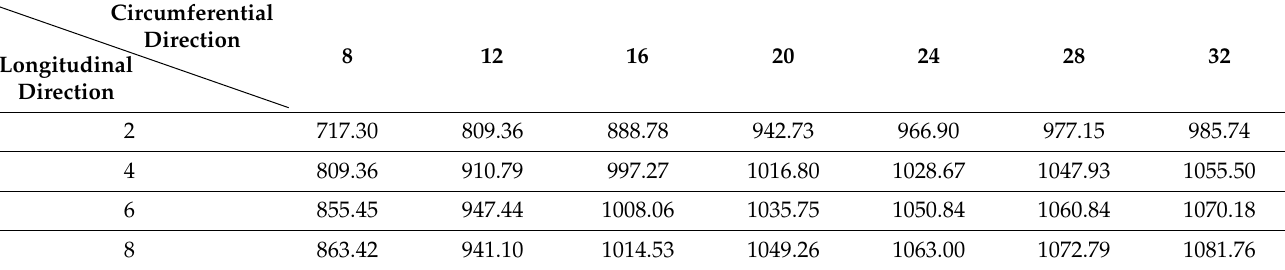
Table 7. Comparison of maximum strain in the piping